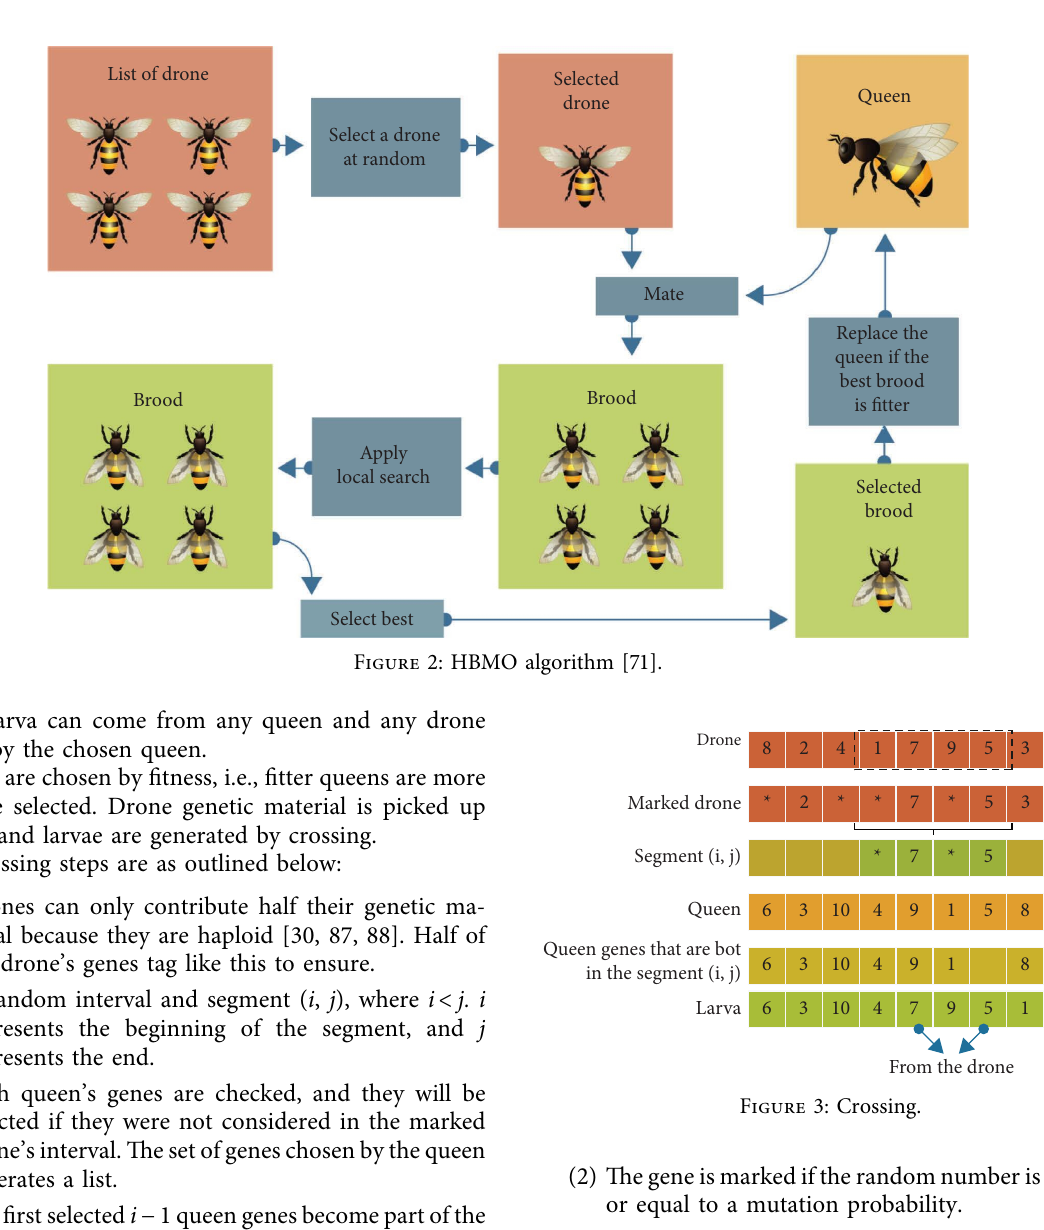
Figure 3: Crossing.